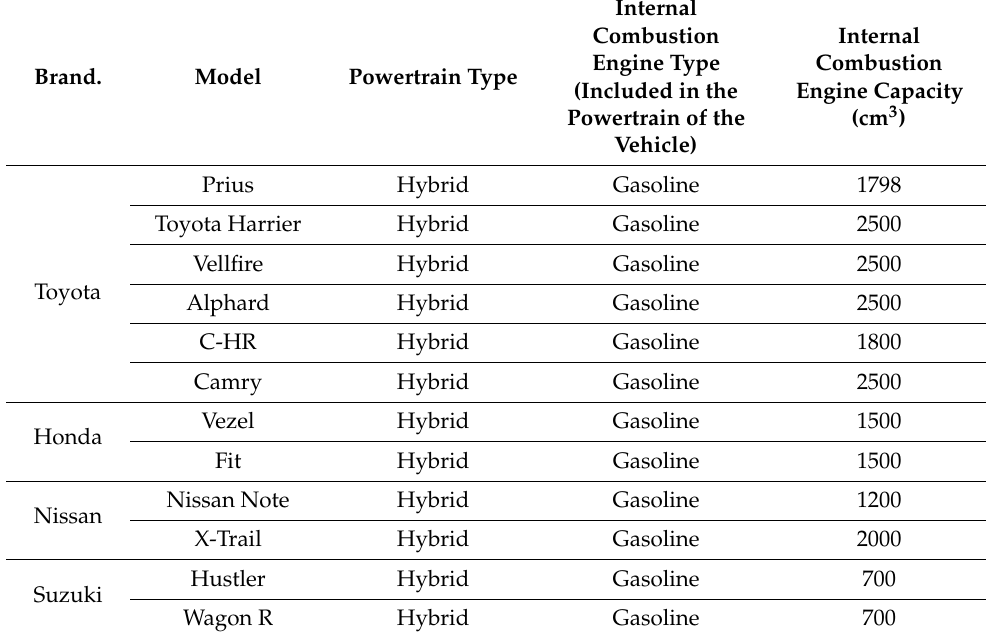
Table 1. Main models of hybrid vehicles sold in the regions of the far north of the Russian Federation.